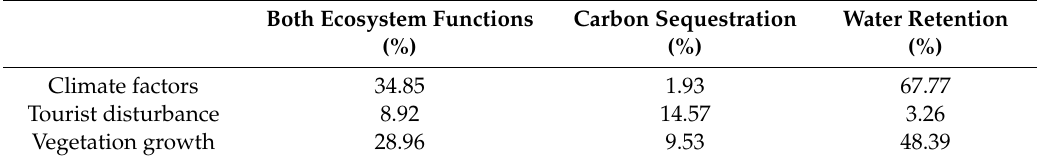
Figure 6. Variance partitioning (%) for two ecosystem functions ( a ), carbon sequestration alone ( b ), and water retention alone ( c ). The variables are tourist disturbance (TD), vegetation growth (VG), and climate factors (CF). Table 4. Total contribution of climate factors, tourist disturbance, and vegetation growth to ecosystem function variation; this result was statistically significant ( p <